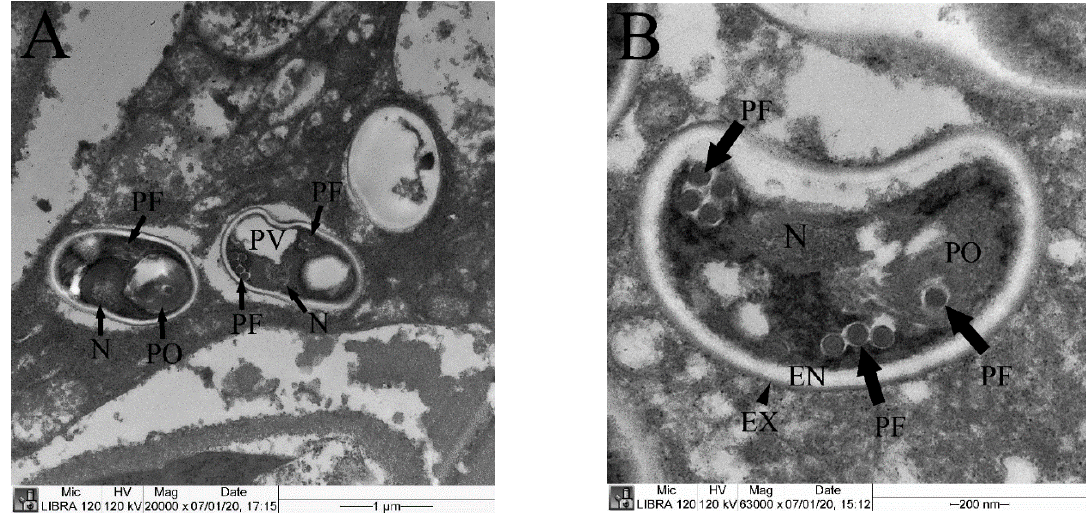
Figure 4. Transmission electron microscopy images of the hepatopancreas from Pacific whiteleg shrimp infected with EHP. ( A ) Mature spores showing a polar filament (PF), polaroplast (PO), nucleus (N) and posterior vacuole (PV). ( B ) Mature spore showing an endospore (EN), exospore (EX), polar filament (PF), polaroplast (PO) and nucleus (N).